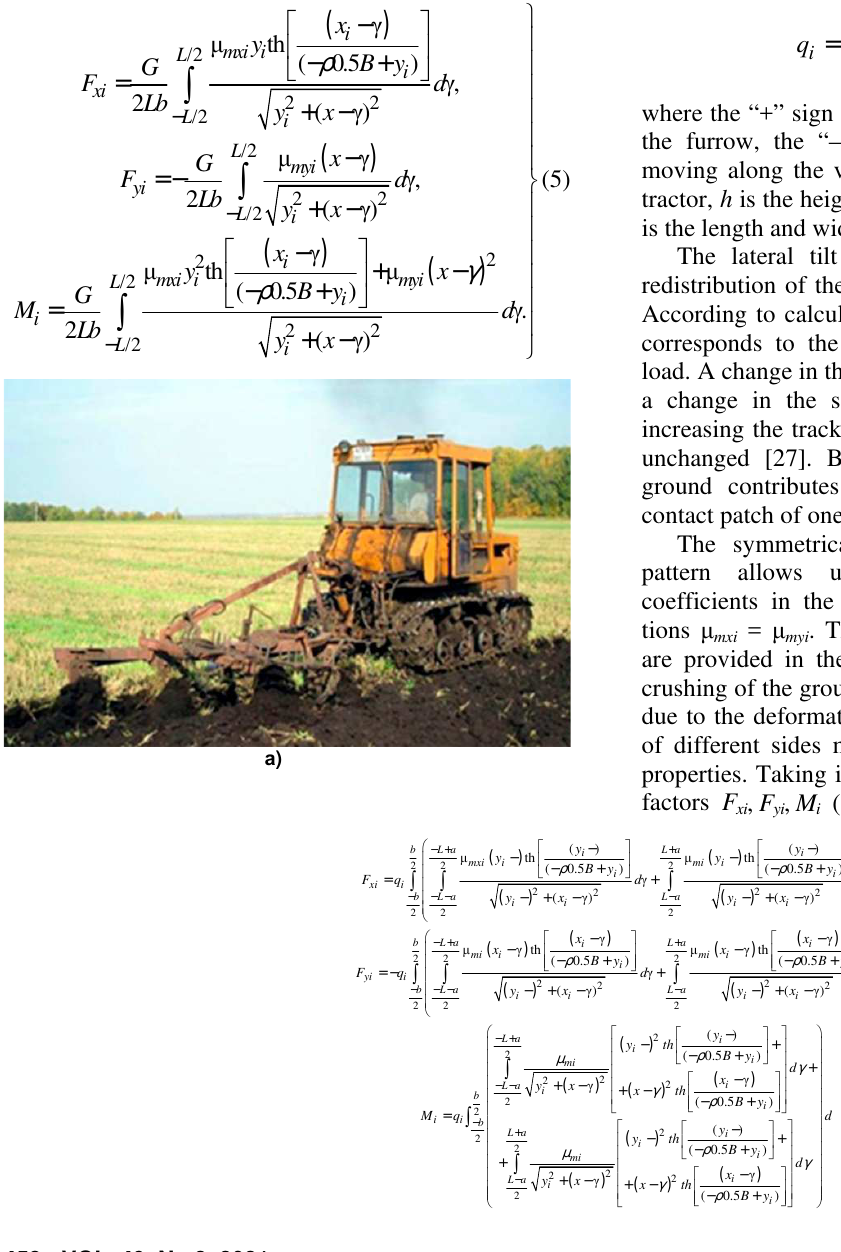
Figure 2. Movement of (a) a caterpillar and (b) wheeled tractor during plowing Characteristics of the wheeled unit movement . The technology of plowing with a wheeled plowing unit implies the movement of the wheels of one side along the bottom of the furrow (Fig. 2b). This results in a constant lateral tilt of the machine. The consequence is a different normal load on the sides determined by [12]: